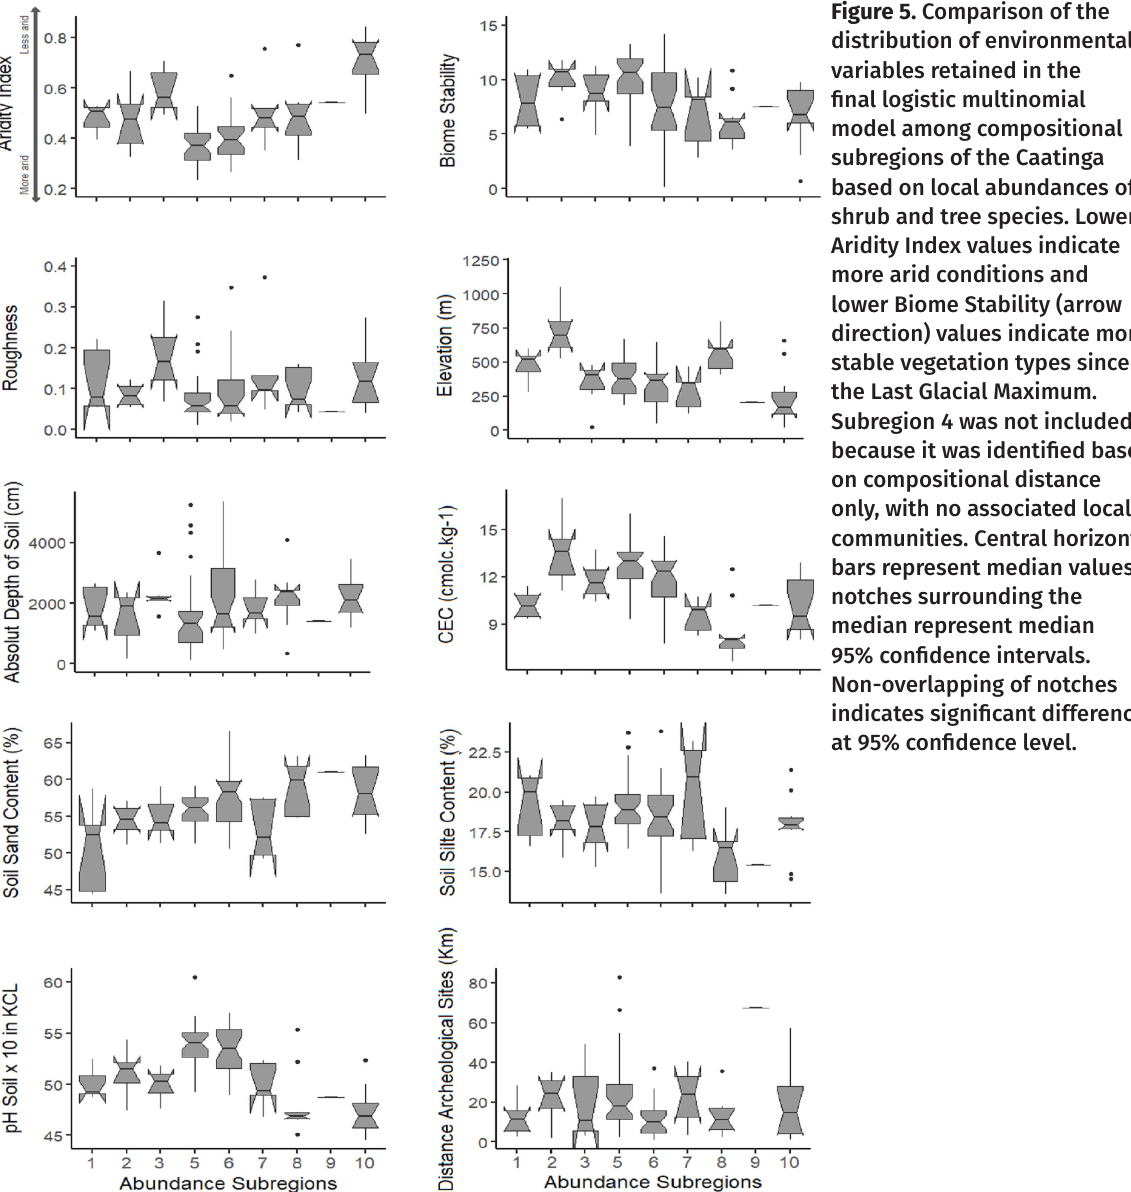
Figure 5. Comparison of the distribution of environmental variables retained in the final logistic multinomial model among compositional subregions of the Caatinga based on local abundances of shrub and tree species. Lower Aridity Index values indicate more arid conditions and lower Biome Stability (arrow direction) values indicate more stable vegetation types since the Last Glacial Maximum. Subregion 4 was not included because it was identified based on compositional distance only, with no associated local communities. Central horizontal bars represent median values; notches surrounding the median represent median 95% confidence intervals. Non-overlapping of notches indicates significant difference at 95% confidence